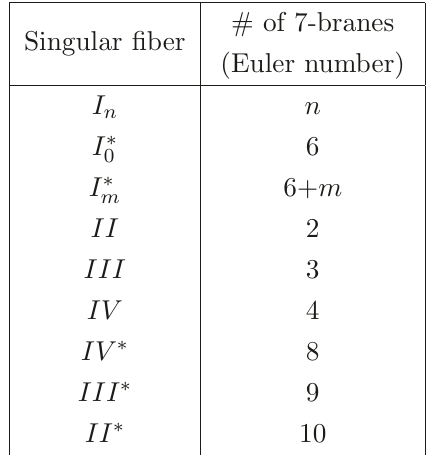
Table 3 . Associated numbers of 7-branes for types of singular